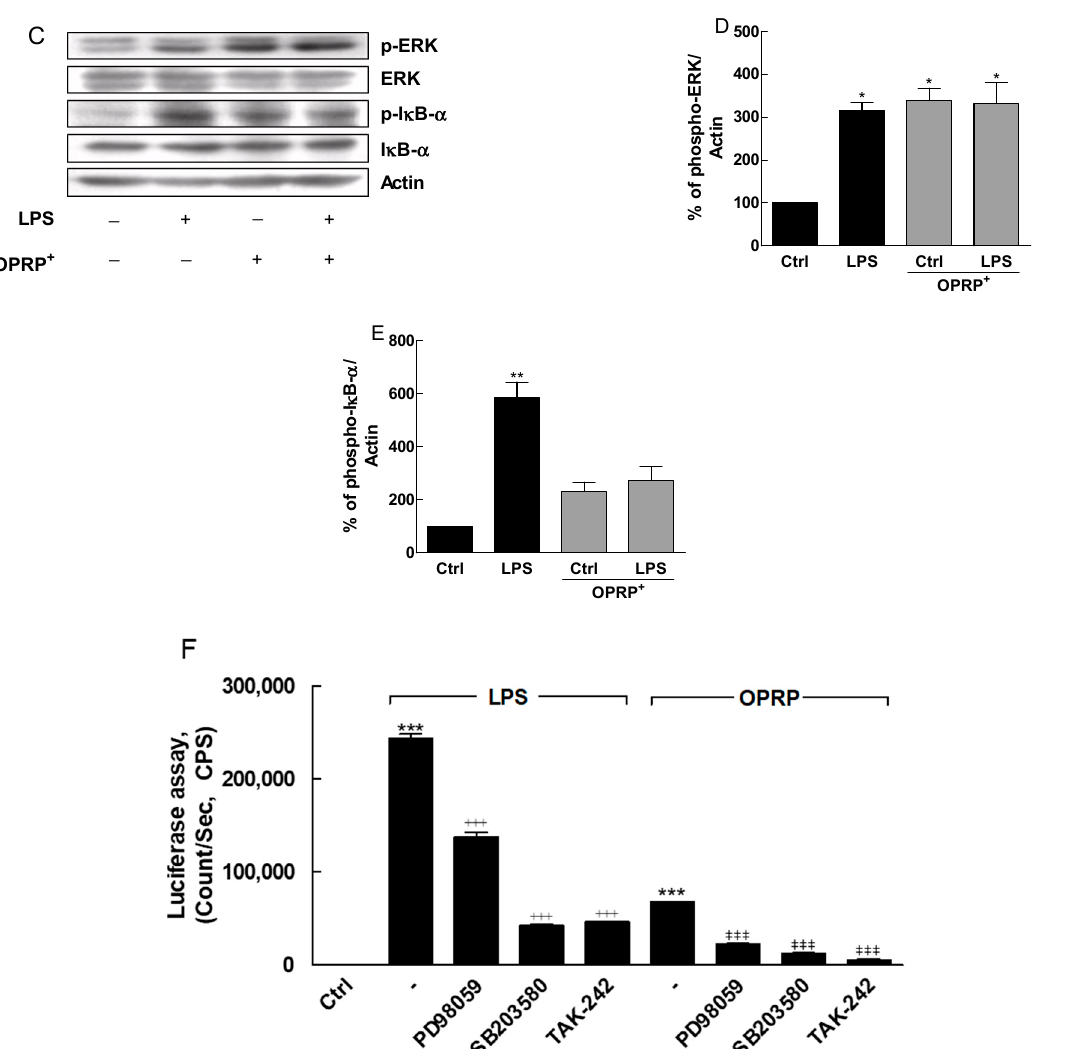
Figure 1. OPRP-transfected Raw264.7 and TLR4-mediated signaling pathway. Raw264.7 (OPRP − ) and OPRP-transfected Raw264.7 (OPRP + ) cells were stimulated by LPS (1 μ g/mL) for 16 h. Differ- ences between OPRP − and OPRP + cells in confocal fluorescence microscopy were then compared. ( A ) OPRP-transfected Raw264.7 cells were stained with Alexa Fluor 647-conjugated secondary an- tibody. Hoechst 33,342 (blue, nucleus) was counterstained and images were merged to distinguish OPRP expression in the cytosol (arrow indicates a magnified single cell picked from a merged picture, whereas outer and inner triangle indicates cell membrane and nuclear, respectively). Scale bar, 20 µ m. ( B ) Intensity profiles (a region of interest, ROI) obtained with ImageJ plot analysis. ( C – E ) TLR4-mediated NF- κ B signaling (phosphorylation of ERK and I κ B- α ) was assessed by Western blot analysis. ( F ) NF- κ B reporter gene assay was performed in THP1-Lucia cells as described in Materials and Methods in the presence of LPS or OPRP for 24 h. Cells were pre-treated with PD98059 (150 µ M), SB203580 (100 µ M), or TAK-242 (5 µ g/mL) for 2 h before treatment with LPS and OPRP. Results are presented as means ± standard deviations from three separate experiments. * p < 0.05, ** p < 0.01, *** p < 0.001 vs. non-transfected Ctrl. +++ p < 0.001 vs. LPS. ‡‡‡ p < 0.001 vs.